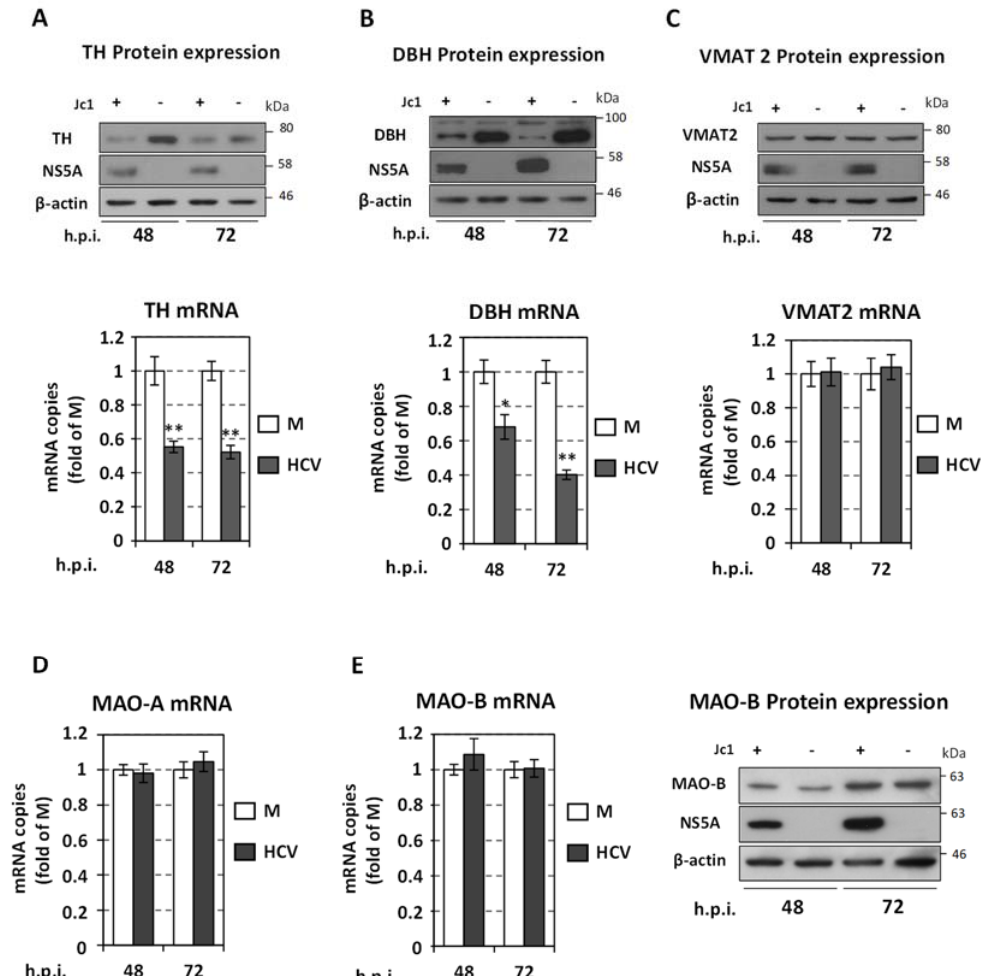
Figure 9. Effect of HCV infection on TH, DBH, VMAT2 and MAO levels. Huh7.5 cells were inoculated with Jc1 (MOI = 1), or mock-infected (M) and further cultured for the indicated h.p.i. ( A – C upper and E right panels). Western blot analysis using anti-TH ( A ), anti-DBH ( B ), anti-VMAT2 ( C ) or anti MAO-B ( E ) antibodies. Viral infection was confirmed using anti-NS5A antibody. Mock-infected cells were used in parallel and are symbolized as Jc1 ( − ). β -actin was used as loading control. A representative experiment of three independent repetitions is shown. ( A – C lower panel, D , E left panel) RT-qPCR analysis of TH, DBH, VMAT2, MAO-A and MAO-B mRNA levels normalized to YWHAZ mRNA. Values are expressed relative to the ones derived from mock-infected (M) cells, at each time-point. Bars represent mean values from three independent experiments in triplicate. Error bars indicate standard deviations. * p < 0.01, ** p < 0.001 vs.